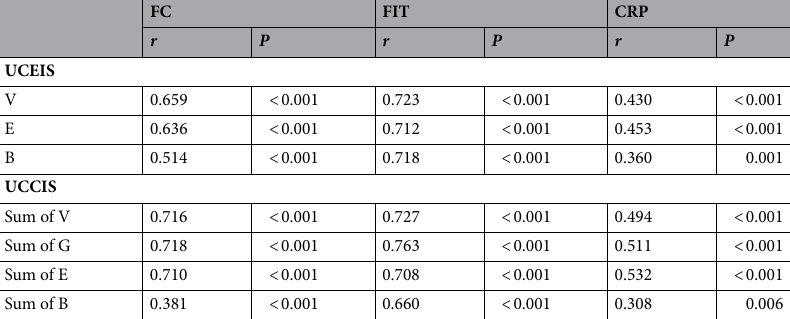
Table 3. Correlations between biomarkers and the descriptors of UCIES/UCCIS. UCEIS Ulcerative colitis endoscopic index of severity, UCCIS Ulcerative colitis colonoscopic index of severity, FC Fecal calprotectin, FIT Fecal immunochemical occult blood test, CRP C-reactive protein, r Correlation coefficient, V Vascular pattern, E Erosions and ulcers, B Bleeding, Sum of V Sum of vascular pattern, Sum of G Sum of granularity, Sum of E Sum of erosions and ulcers, Sum of B Sum of bleeding/friability.